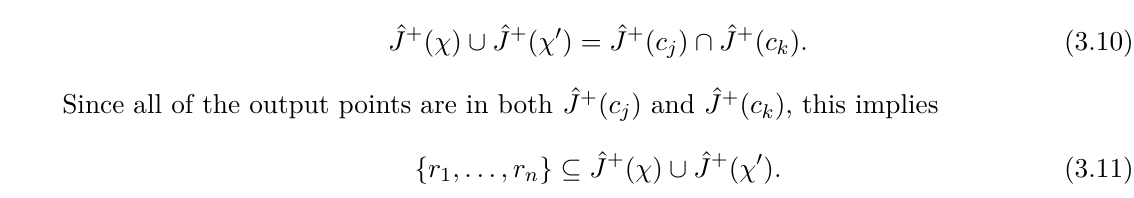
meets the Cauchy surface Σ at y j + , − meets sigma as p . Because all V must lie to the past of all r r j , + k + and γ , so p must not be to the r j , + r j , − + + or a x by the counting argument, we must have p = x i i